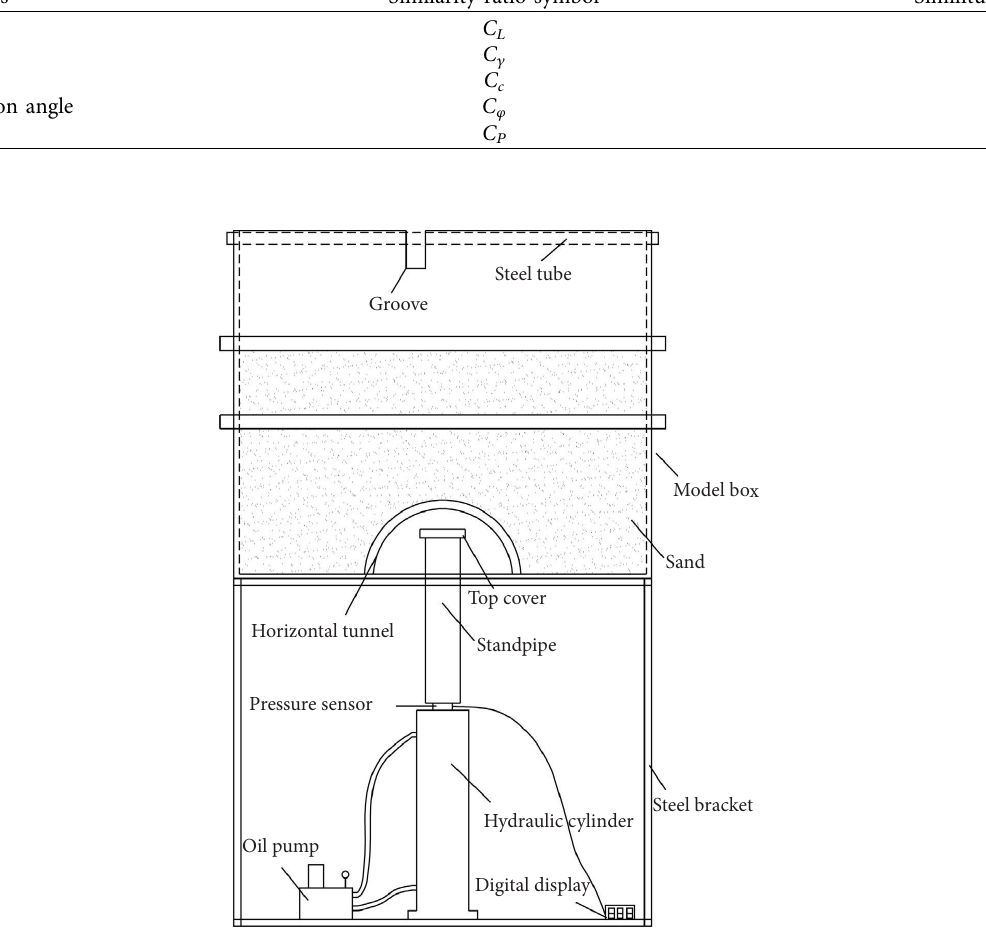
Figure 2: Schematic sketch of the indoor model